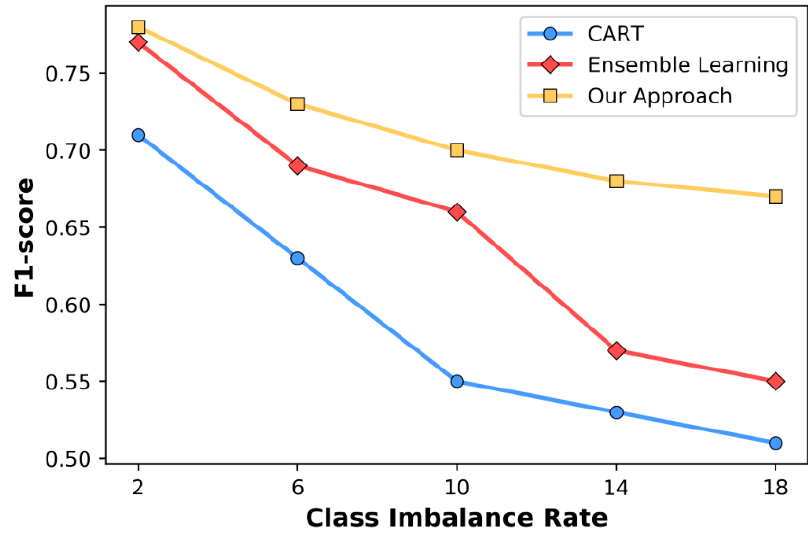
Figure 6. F1-score results in comparison with different class imbalance rates.